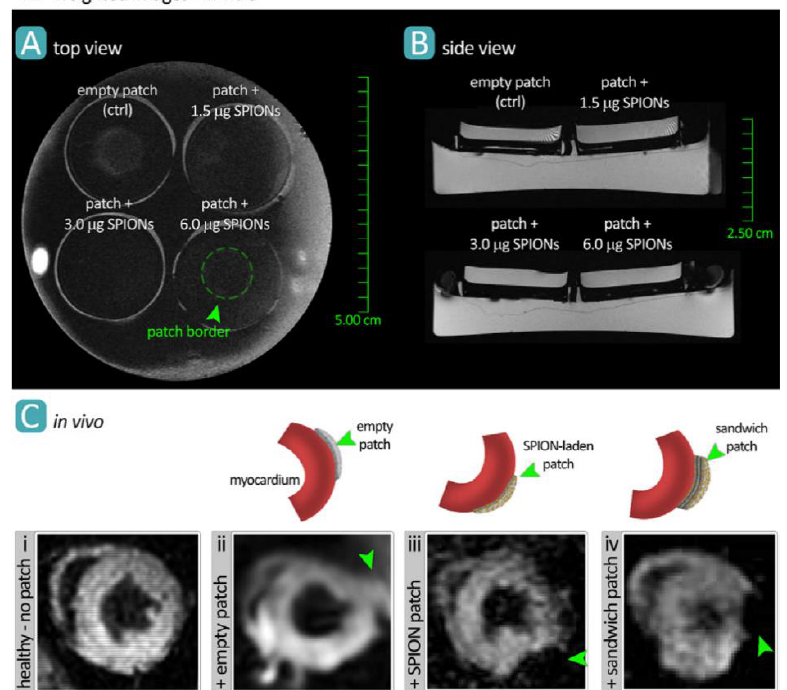
Figure 3. MR imaging of bioengineered collagen constructs used as cardiac patch to repair ischemic heart tissue. Patches were loaded with 1.5, 3.0, and 6.0 μg/mL of iron oxide nanoparticles and imaged via MRI both in vitro ( A , B ) and in vivo ( C ), in a mouse model. Manganese-enhanced MRI visualized the patch grafted onto healthy myocardial tissue in different groups including no treatment (control) ( i ), empty patch ( ii ), nanoparticle-loaded patch ( iii ), and loaded-empty-loaded sandwich patch ( iv ). Reproduced with permission from Ref. [17].